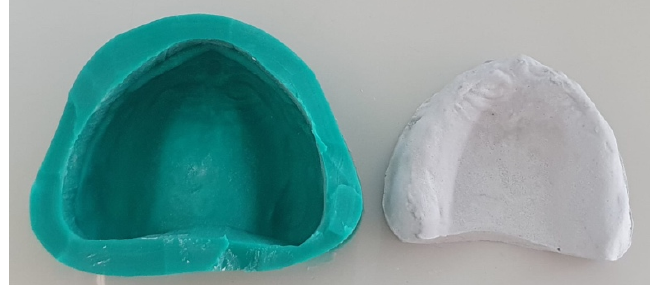
Figure 4. Replicated model.